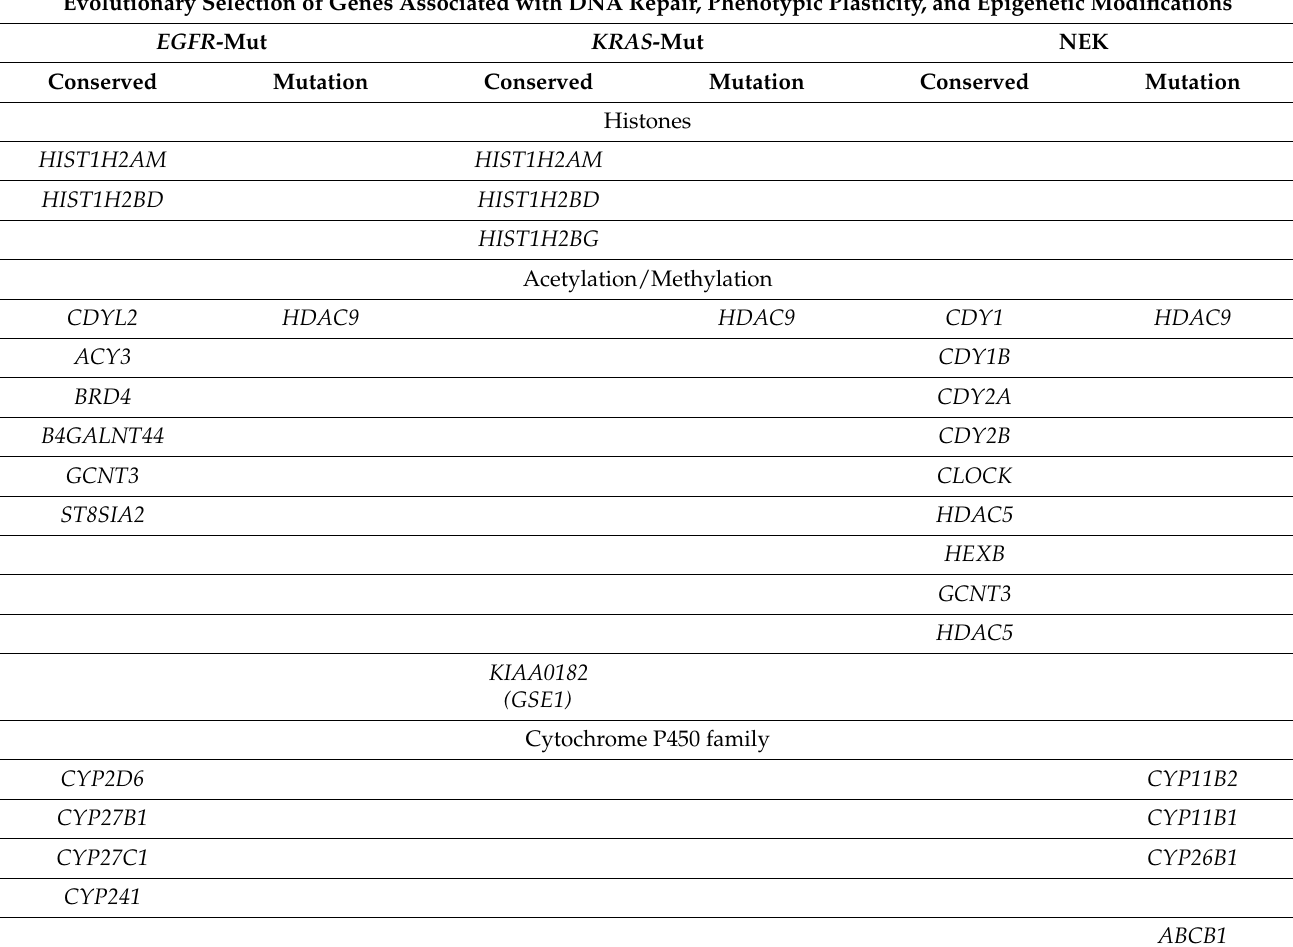
Table 2. Evolutionary selection on genes related to phenotypic plasticity and epigenetic